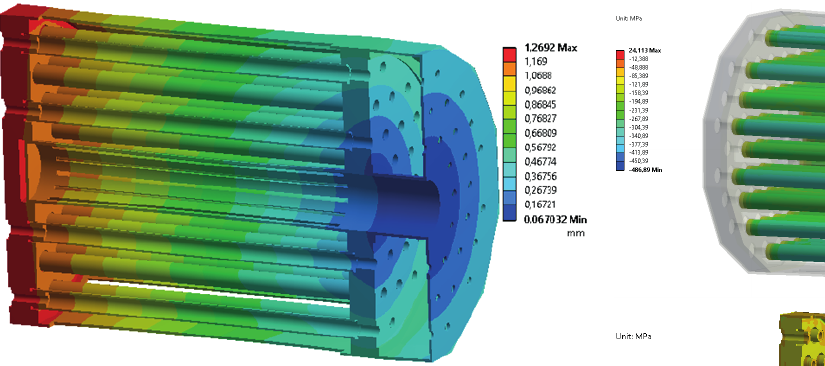
Figure 26: Total displacement of the assembly with supporting structure under thermal stresses.